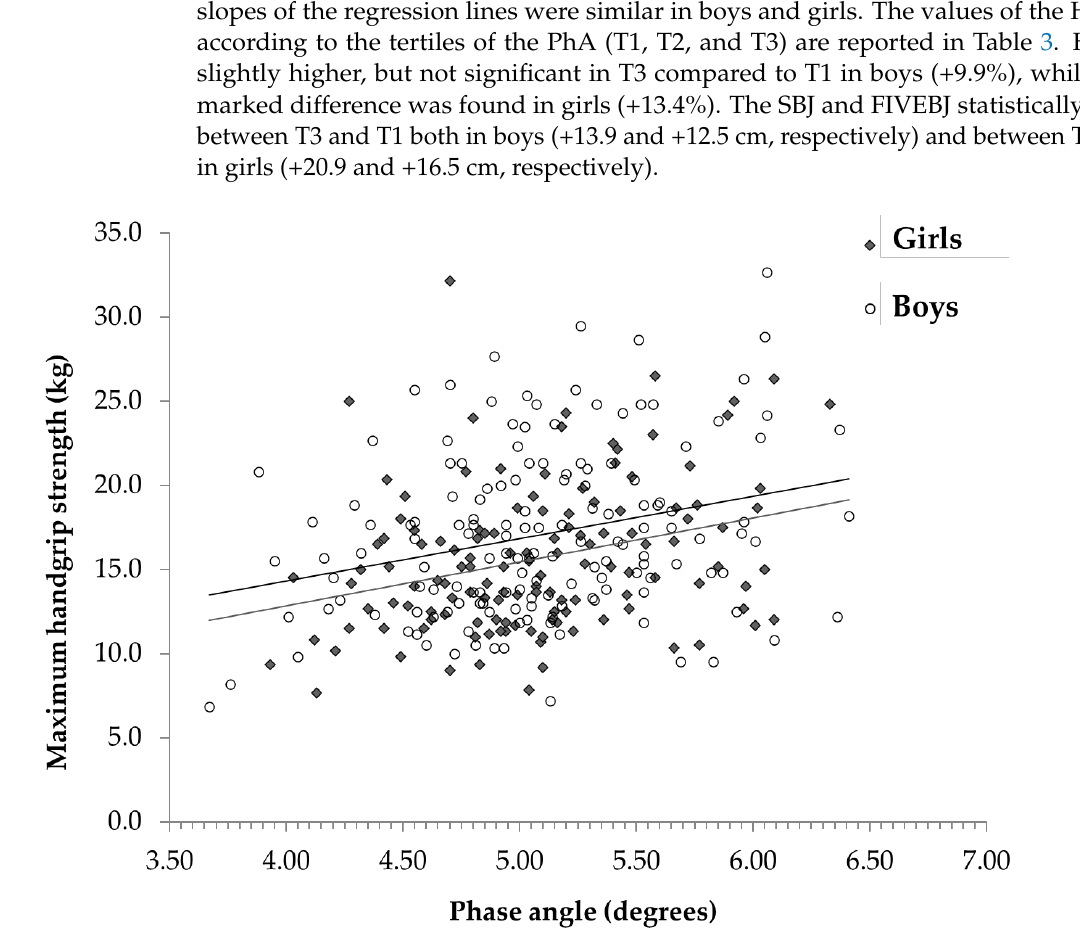
Figure 1. Relationship between maximum handgrip strength and phase angle at 50 kHz in boys and girls.